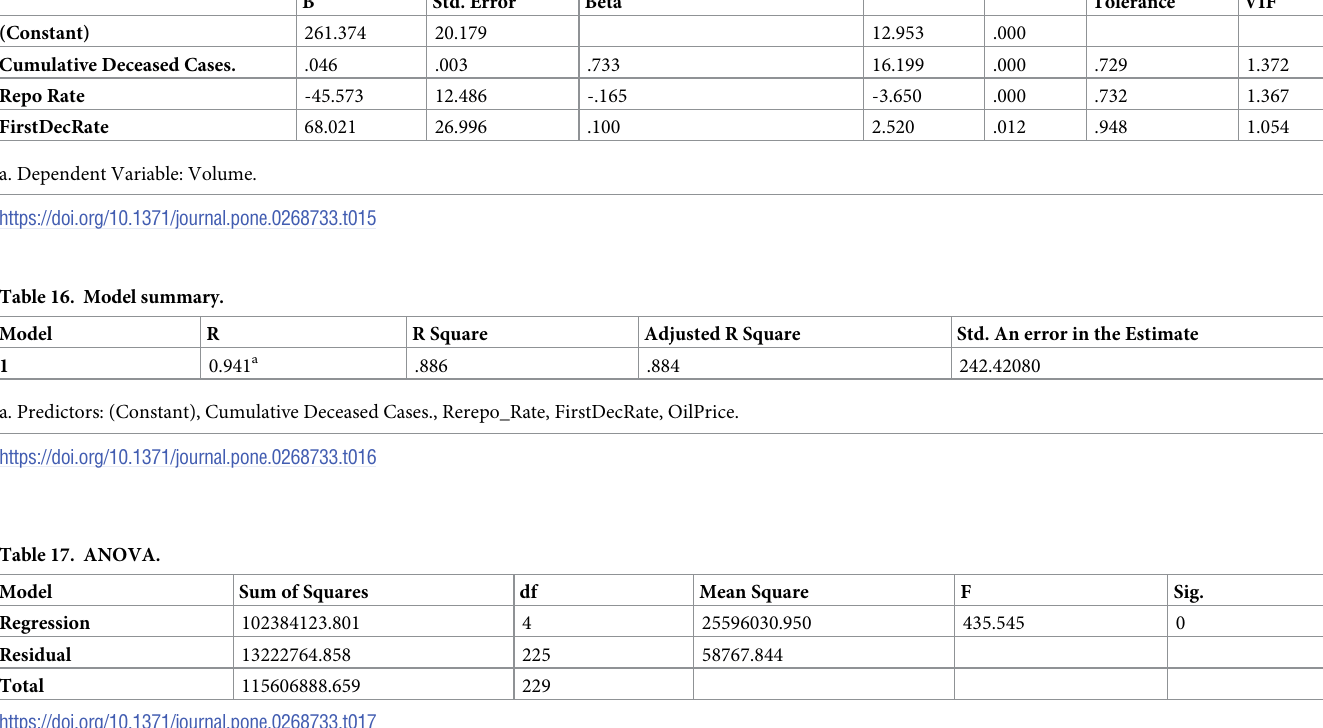
Table 15. Coefficients of trading volume model with control variable. Model